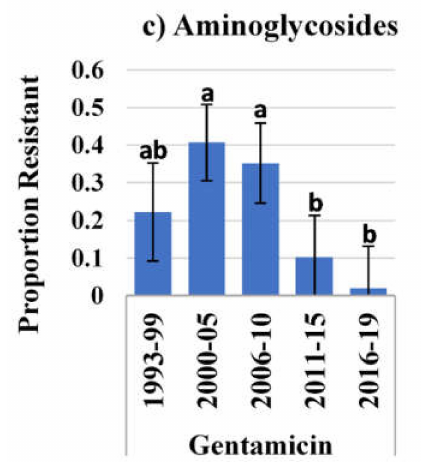
Figure 1. Least square means for antimicrobial resistant proportion for ( a ) cephalosporins, ( b ) quinolones and ( c ) aminoglycoside drugs. Letters are the output from Tukey-Kramer pairwise analysis, and different letters indicate a significant difference between year intervals for a referred drug. * Year interval not included in the pairwise analysis because no isolate was resistant to the referred drug during that year